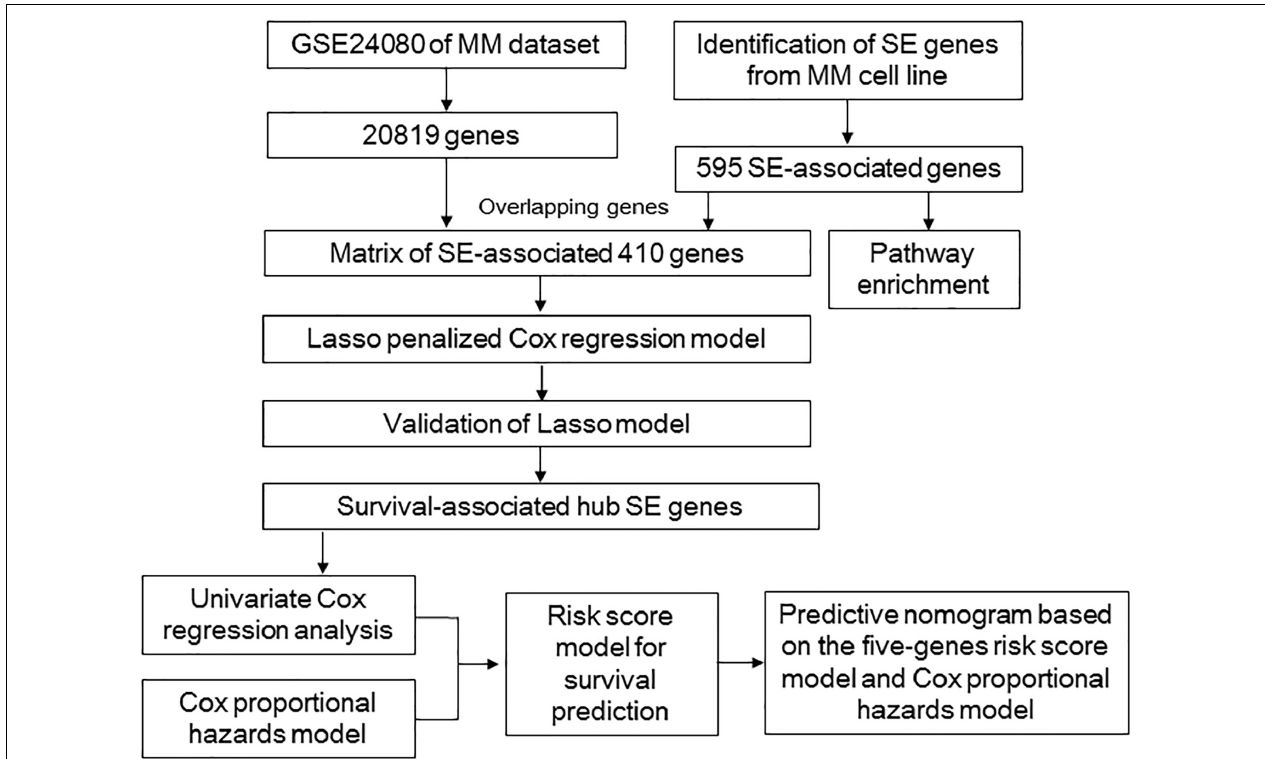
FIGURE 1 | Overall design to develop and validate the prognostic model for multiple